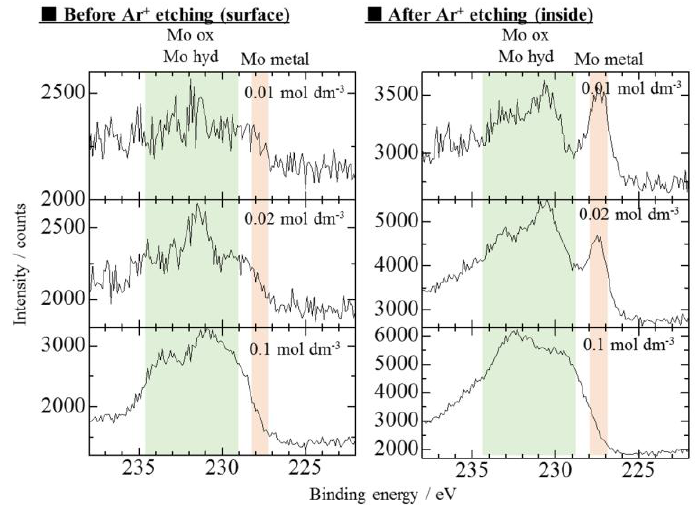
Figure 14. XPS analysis results of the Zn–Fe–Mo plating deposited from a plating bath with different Mo concentrations.